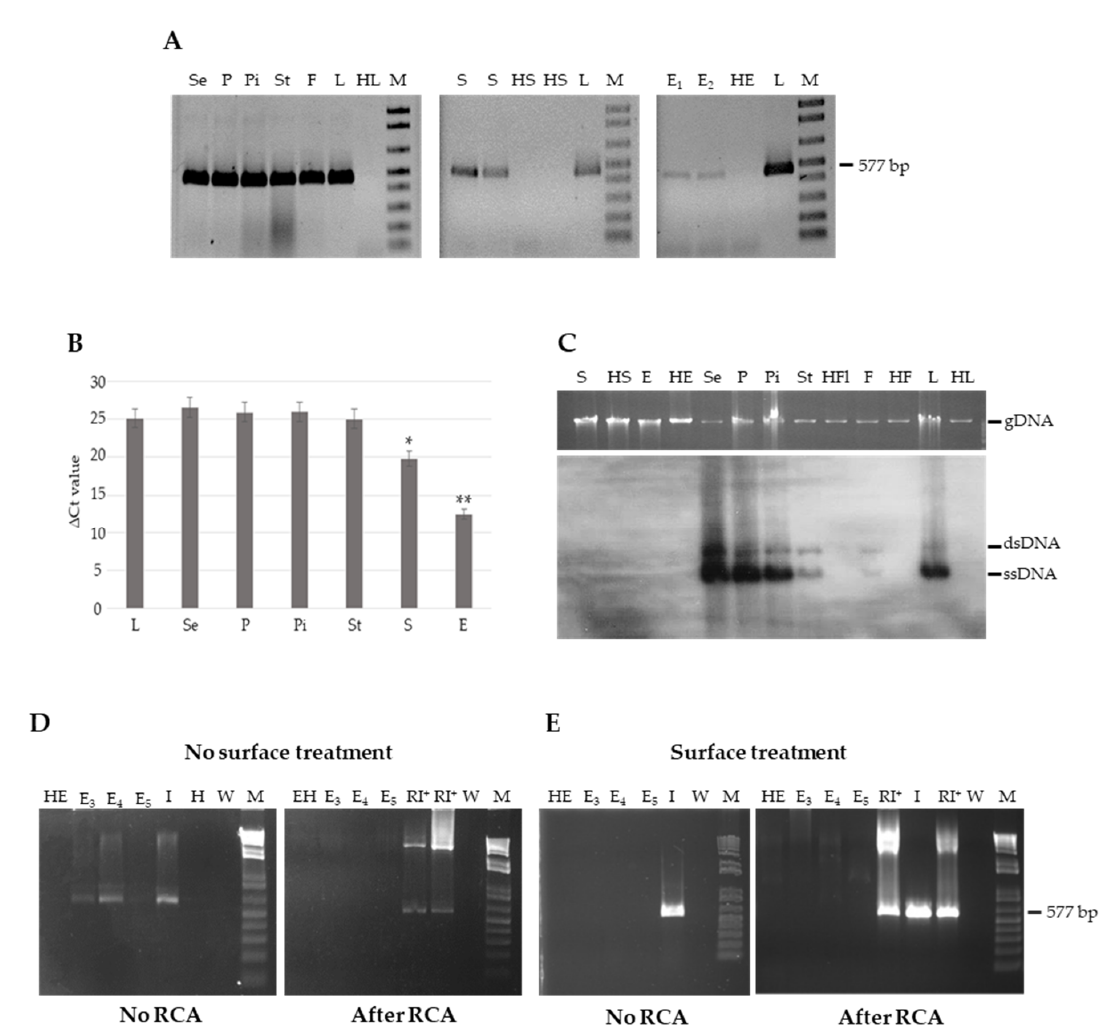
Figure 3. Detection of TYLCSV DNA in different tissues of infected tomato plants. ( A ) PCR analysis using the TY1(+)/TY2( − ) primers. ( B ) Quantification of TYLCSV DNA by qPCR. The Y-axis indicates the ∆ Ct value, calculated as follows: ∆ Ct = |Ct tissueTYLCSV − Ct SlyAPX |. Asterisks indicate significant differences (Kruskal–Wallis test, p -value < 0.05). ( C ) Southern blot analysis with a coat-protein-specific probe. ssDNA and dsDNA, TYLCSV single-stranded genomic and double-stranded replicative forms, respectively; gDNA, host genomic DNA loading, shown as control. ( D , E ) PCR analysis of embryos ( n = 18–20, from three different plants) extracted immediately after dissection (No surface treatment) or following a sterilization step (Surface treatment). PCRs were performed directly on DNA samples (No RCA) or on RCA products obtained with the same extracts (After RCA). Unless indicated, all samples were collected from infected plants and from surface sterilized seeds. Se, sepals; P, petals; Pi, pistils; St, stamens; F, fruits; L, leaves; HL, healthy leaves; S, seeds; HS, healthy seeds; E 1–5 , embryos (five different batches); HE, healthy embryos; HFl, healthy flowers; HF, healthy fruits; I, infected plant, positive control; H, healthy plant, negative control; RI + , RCA on infected plant, positive control (two different samples); W, water control; M, 1 kb Plus DNA Ladder (Invitrogen, Thermo Fisher Scientific, Waltham, MA,